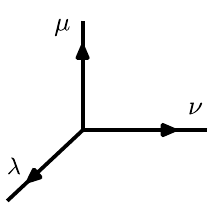
Figure 10 . The pictorial description of the topological vertex.